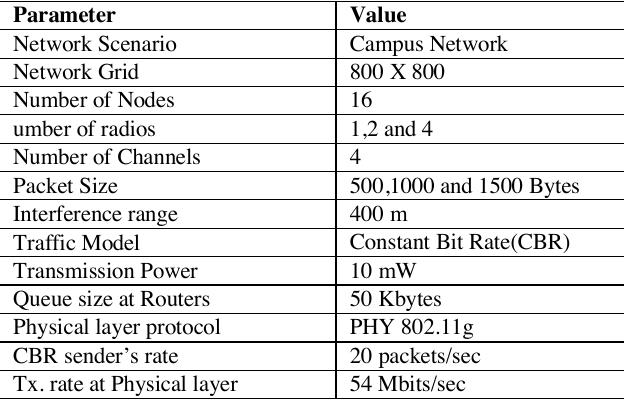
Table 1. Simulation